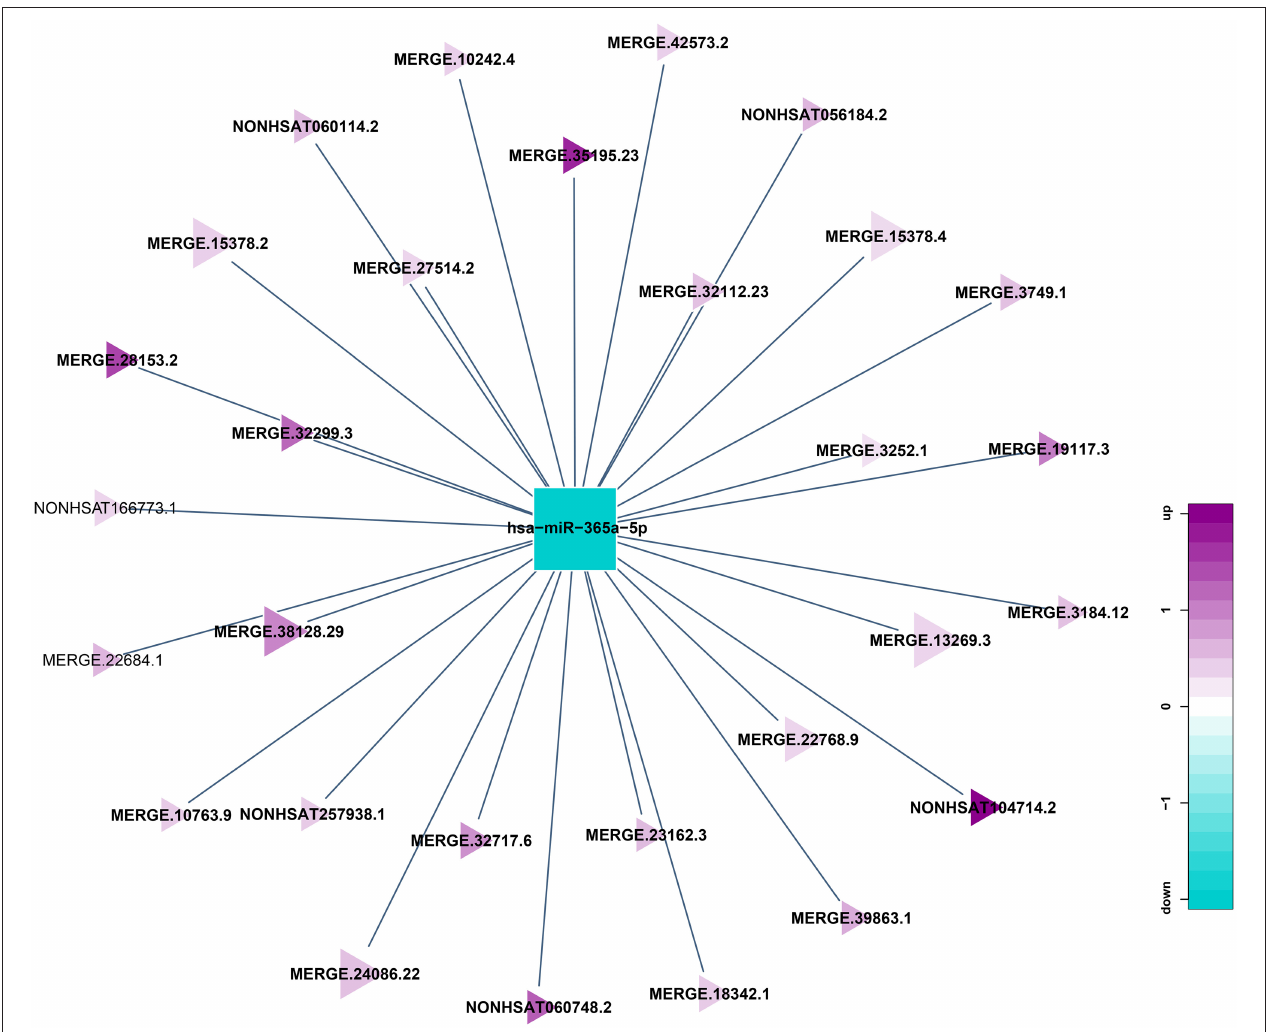
FIGURE 7 | Correlation analysis diagram of hsa-miR-365a-5p-lncRNA (Squares: miRNA; Triangle: lncRNA; Blue: down-regulation; Purple: